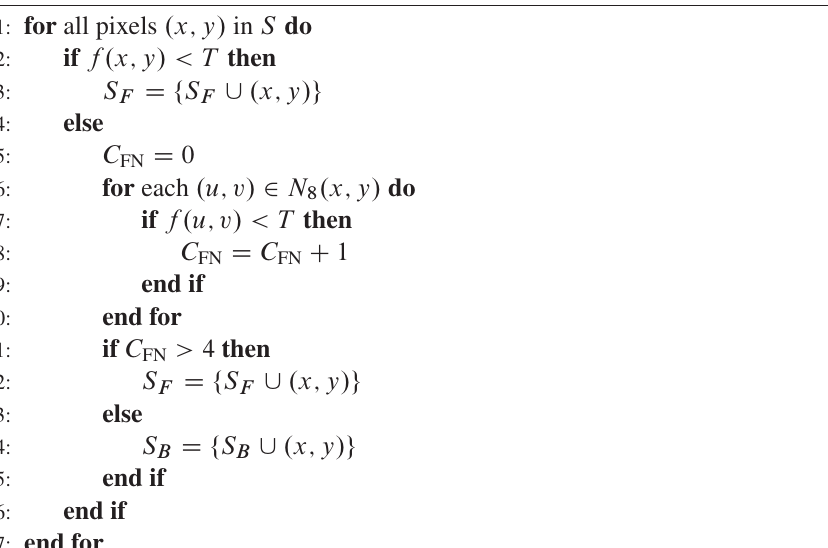
Algorithm 1 Text Region Binarization